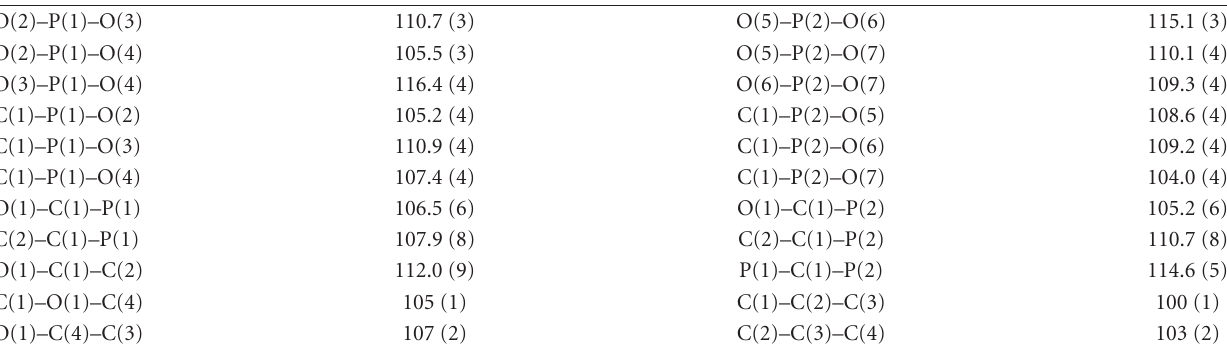
Table 3: Selected bond angles ( ◦ ) for Na 2 H 2 L.